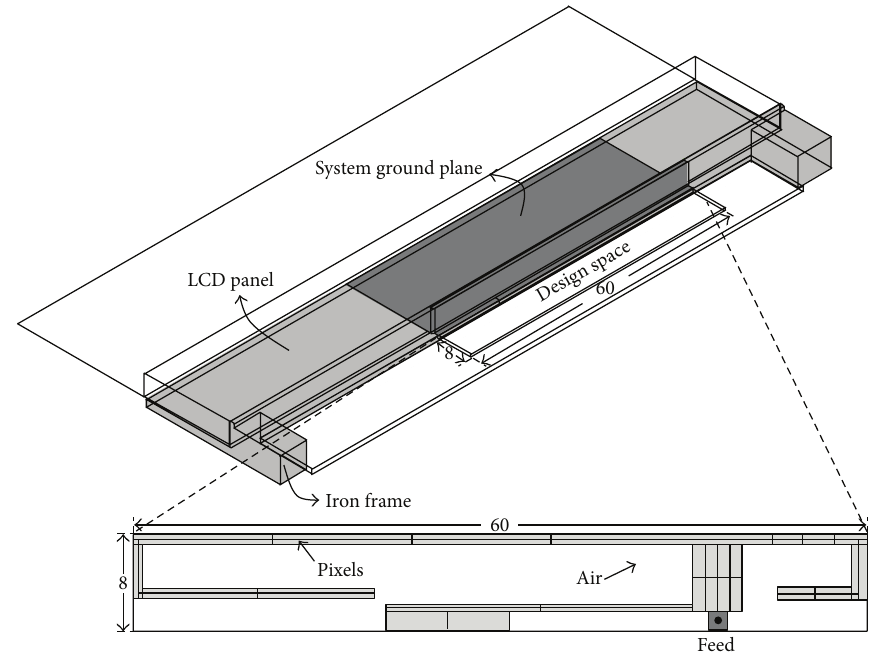
Figure 15: Geometry of the internal antenna for laptop applications and the discretization of the design space (unit: mm).